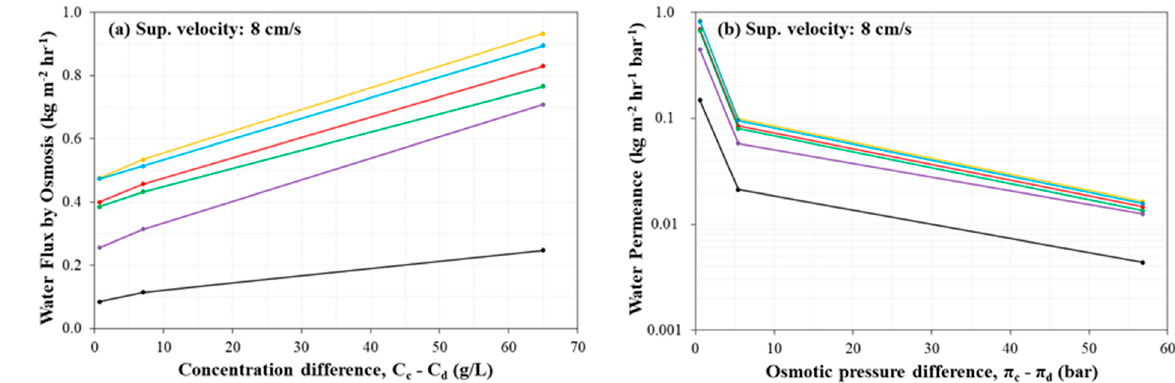
Figure 6. Water flux by osmosis versus concentration difference ( a ) and osmotic permeance versus osmotic pressure dif- ference ( b ). Experimental conditions: Five cell-pairs stack; 0.7, 7, and 65 g/L initial concentration differences between NaCl concentrate and diluate streams (500 mL each) corresponding to 0.6, 5.4, and 56.1 atm osmotic pressure differences be- tween NaCl concentrate and diluate stream, respectively; 8 cm/s superficial velocity of feed solution; no applied stack voltage per cell-pair; 0.1 M (14.2 g/L) Na 2 SO 4 electrode rinse solution; and 3 kPa transmembrane pressure. Representation of membranes, top to bottom: Orange: SUEZ AR204/CR67, Blue: AMX/SandiaCEM, Red: Neosepta AMX/CMX, Green: PCA PCSK/PCSA, Purple: Fujifilm Type 1 AEM/CEM, Black: Ralex CMH-PES/AMH-PES.